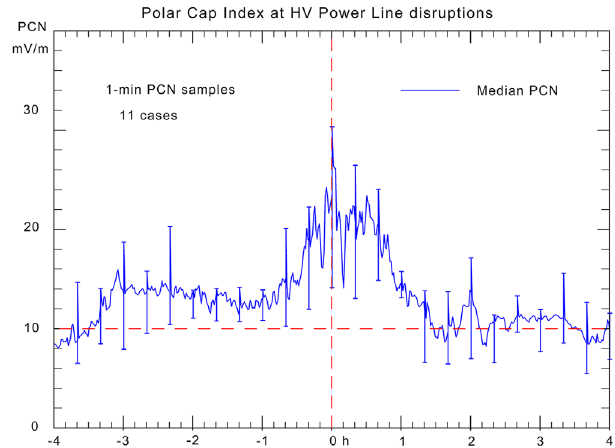
Fig. 3. Median PCN index values relative to times of HV power line disruption events. Error bars indicate standard deviation. (from Stauning, 2013b)